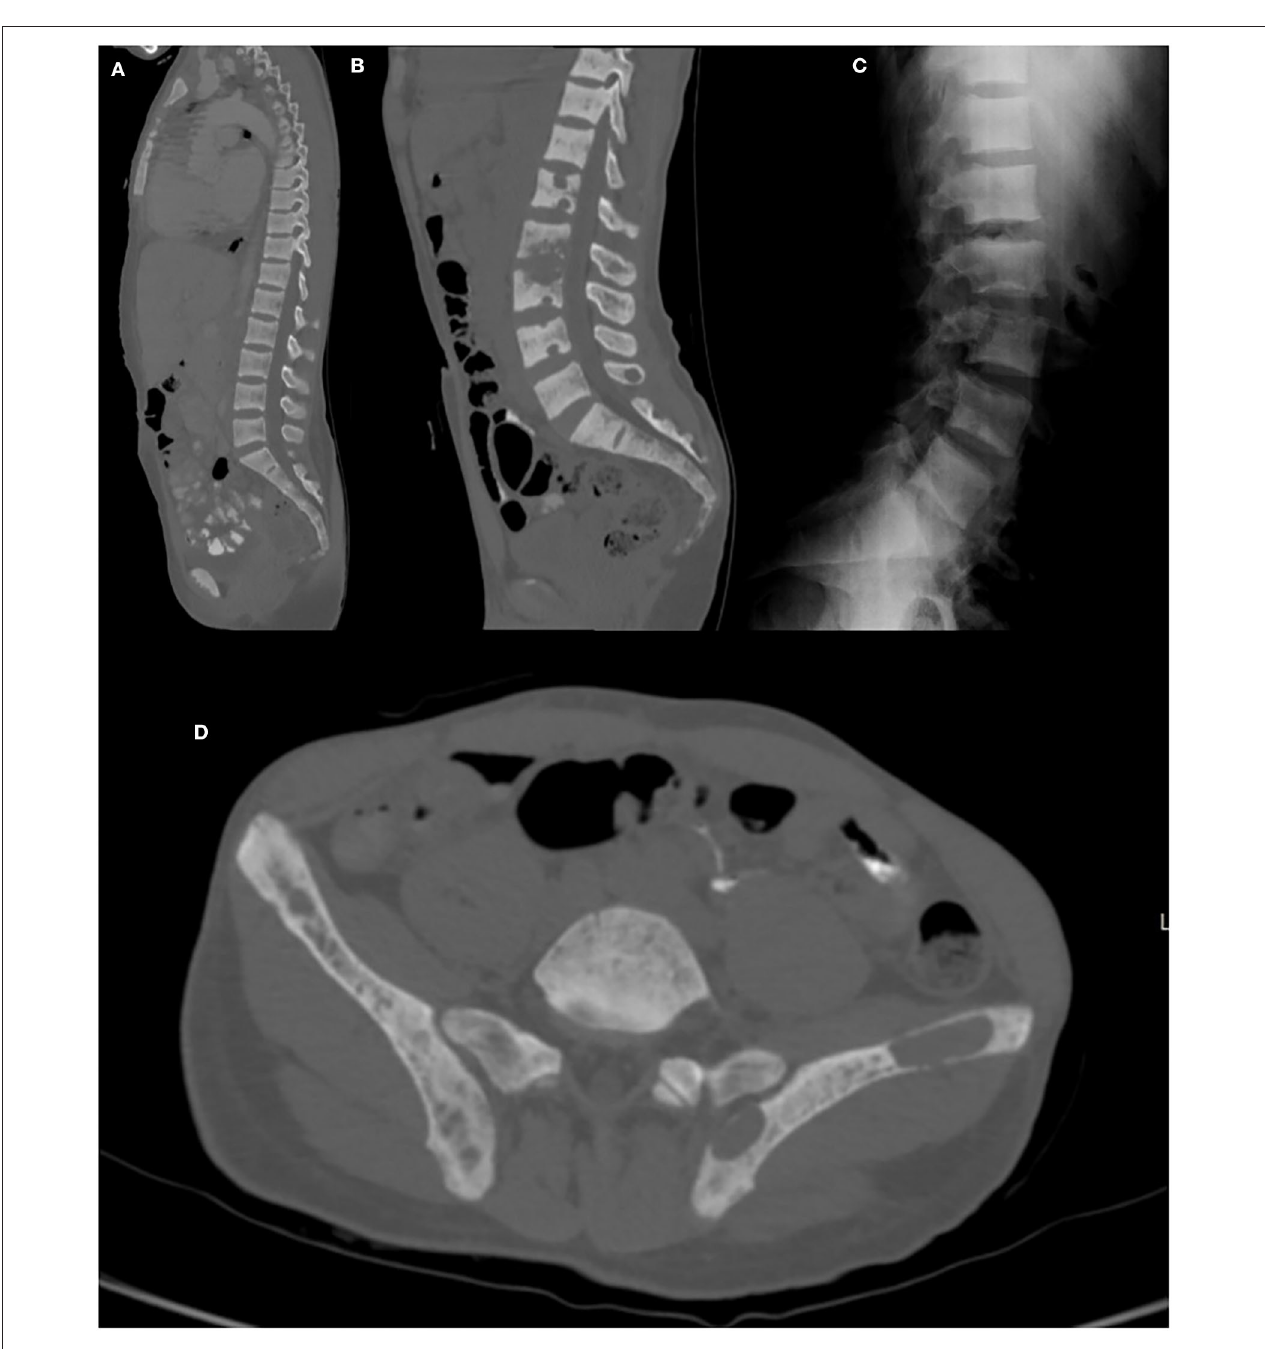
FIGURE 11 | CT sagittal reconstruction of the dorsal and lumbar spine (A,B) of a patient with renal osteodystrophy depicts abnormal bone turnover and mineralization, with diffuse osteosclerosis and multiple areas of subperiosteal resorption. Lateral lumbar spine radiography (C) shows the characteristic “rugger jersey” spine, with alternating bands of increased and normal bone density of the vertebral bodies. Note a large brown tumor of the left iliac bone on CT (D) .